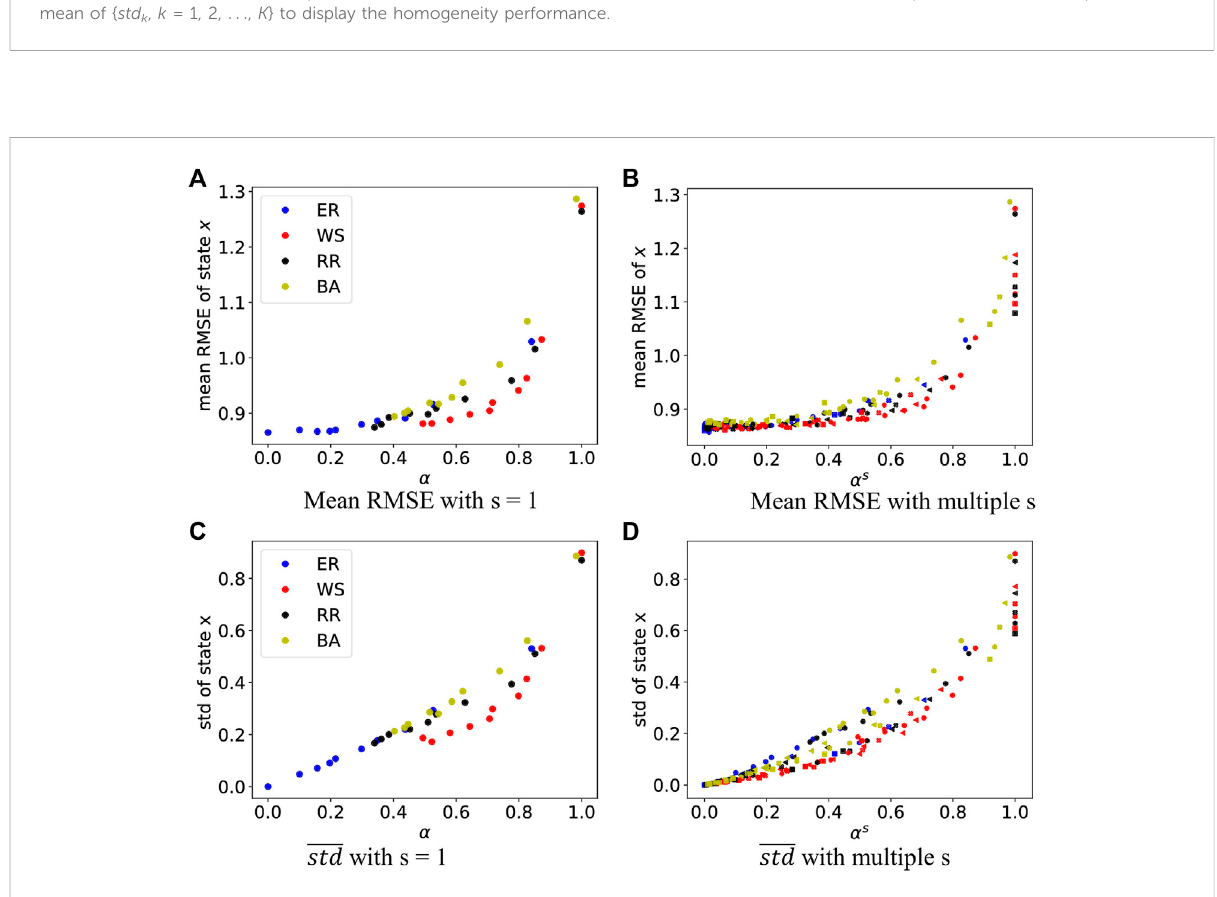
FIGURE 3 Mean RMSE and mean standard deviation of state x on the Lorenz-63 system. Colors represent different network types, and shapes represent communication rounds s . The markers for s = 1, 2, 3, 4, 5 are a circle, left triangle, fi lled X , hexagon, and square respectively. (A,B) display the mean RMSE of state x along with the gossiping rate. (C,D) are plots of the mean std to illustrate the in fl uence of the gossiping rate on the